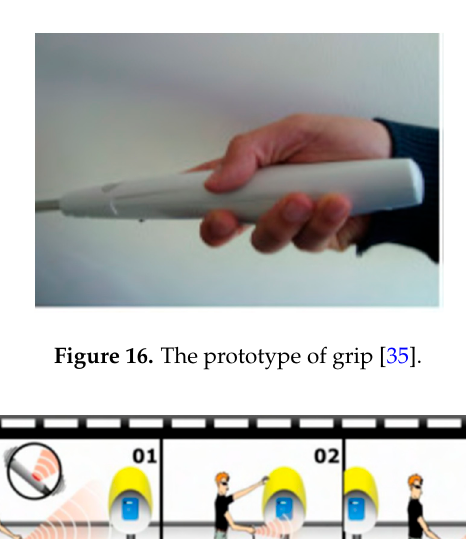
Figure 15. ( a ) The results of the device’s orientation in residential area; ( b ) The results of the device’s orientation in civilian [34].